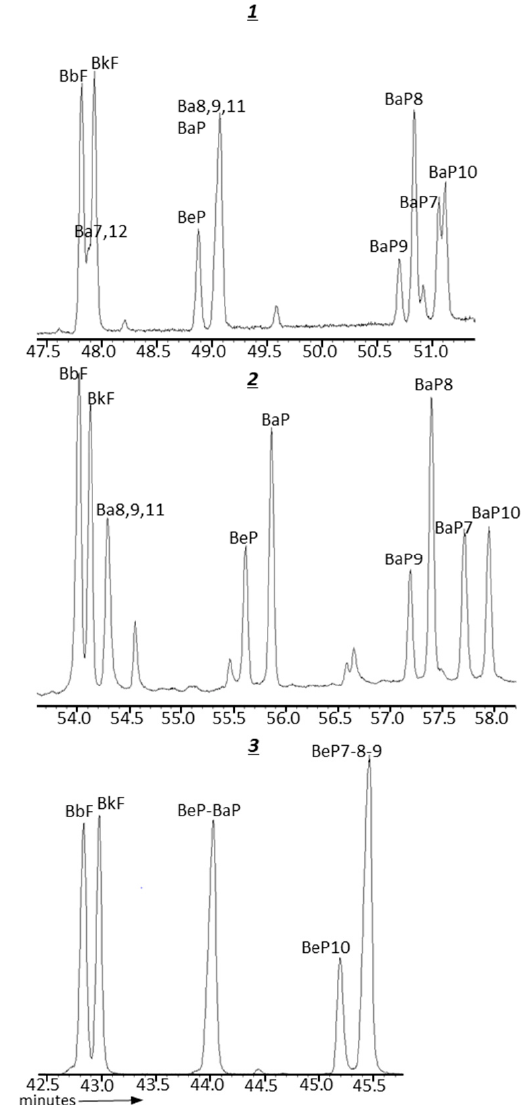
Figure 4. Elution order of benzo( b )fluoranthene, benzo( k )fluoranthene, benzo( e )pyrene, benzo( a )pyrene and methylbenzo( a )pyrenes on phenyl arylene ( 1 ), 50% phenyl-polysiloxane ( 2 ) and SLB-ILPAH ( 3 ) stationary phases. For abbreviations see Table 2.